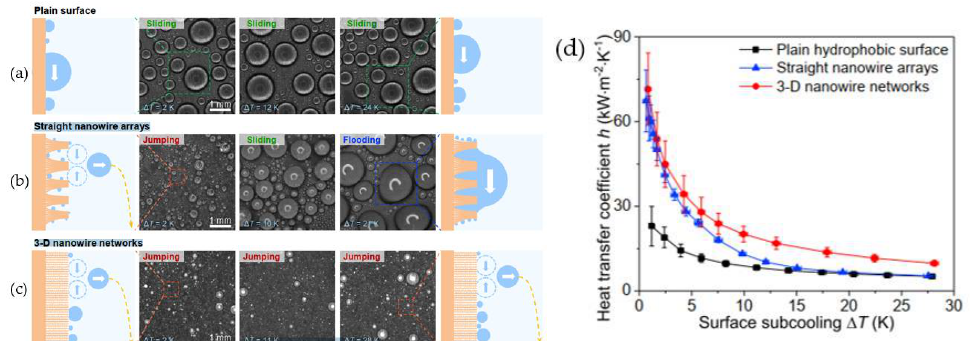
Figure 29. The dynamic behavior of droplets on ( a ) plain hydrophobic. ( b ) straight superhydrophobic nanowire arrays. ( c ) 3D superhydrophobic nanowire networks surfaces. ( d ) The condensation heat transfer coefficient is a function of surface subcooling. Reprinted with permission from Ref [127]. Copyright 2018 Elsevier.